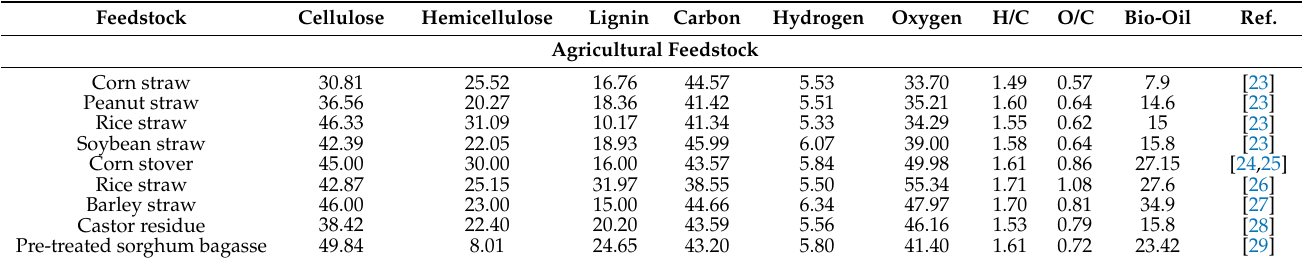
Table 1. Chemical and elemental composition of major feedstock and bio-oil yield. Feedstock Cellulose Corn